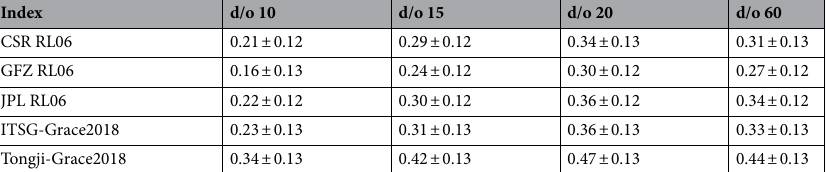
Table 7. The linear trends of GMOM change for five GRACE solutions up to different degree and orders (d/o) from January 2005 to December 2016 except for the degree-1 and C 20 coefficients [unit: mm/year].